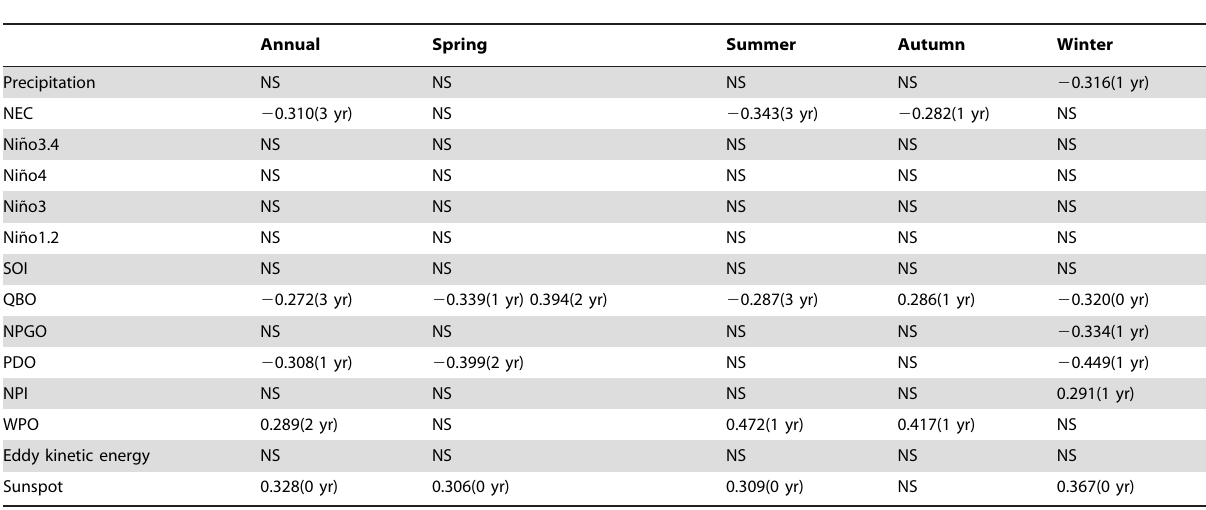
Table 1. Results of regression analyses of log 10 (eel catch) against climate indices.